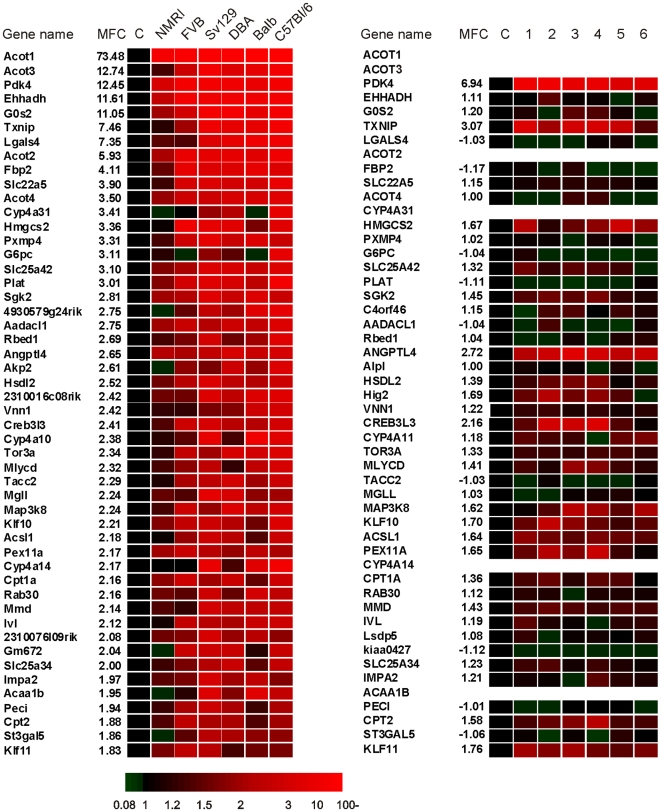
Partial conservation of Wy14643-induced gene regulation between mouse and human hepatocytes.Heat map illustrating the relative induction of the top 50 of upregulated genes in response to 6 h Wy14643 treatment in mouse hepatocytes. All genes were significantly changed (P<0.05) and were ranked based on mean fold-change (MFC). Expression levels in the DMSO-treated cells were set at 1. Relative changes in expression of the corresponding human orthologs in human hepatocytes are shown in parallel.